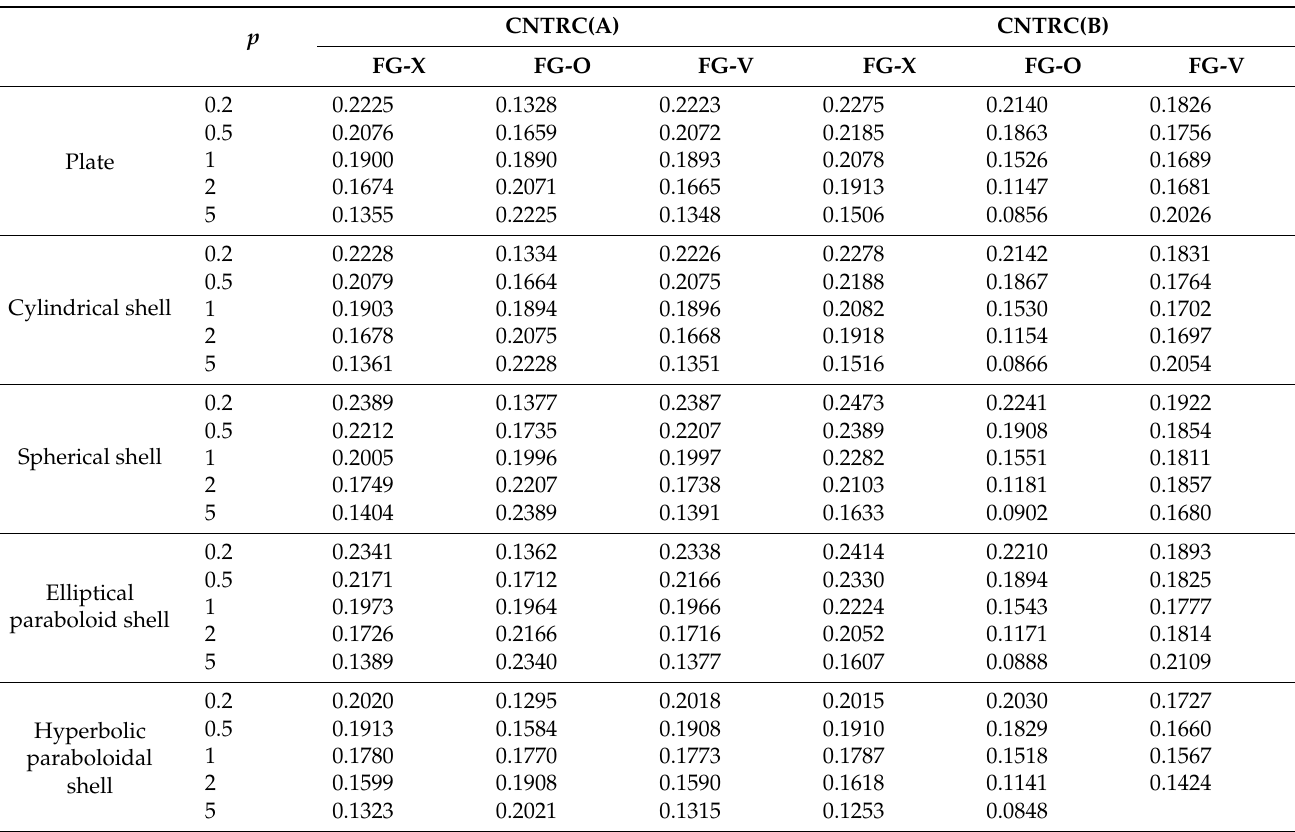
Table 3. Effect of CNTRC type and CNT distribution pattern on the dimensionless frequency